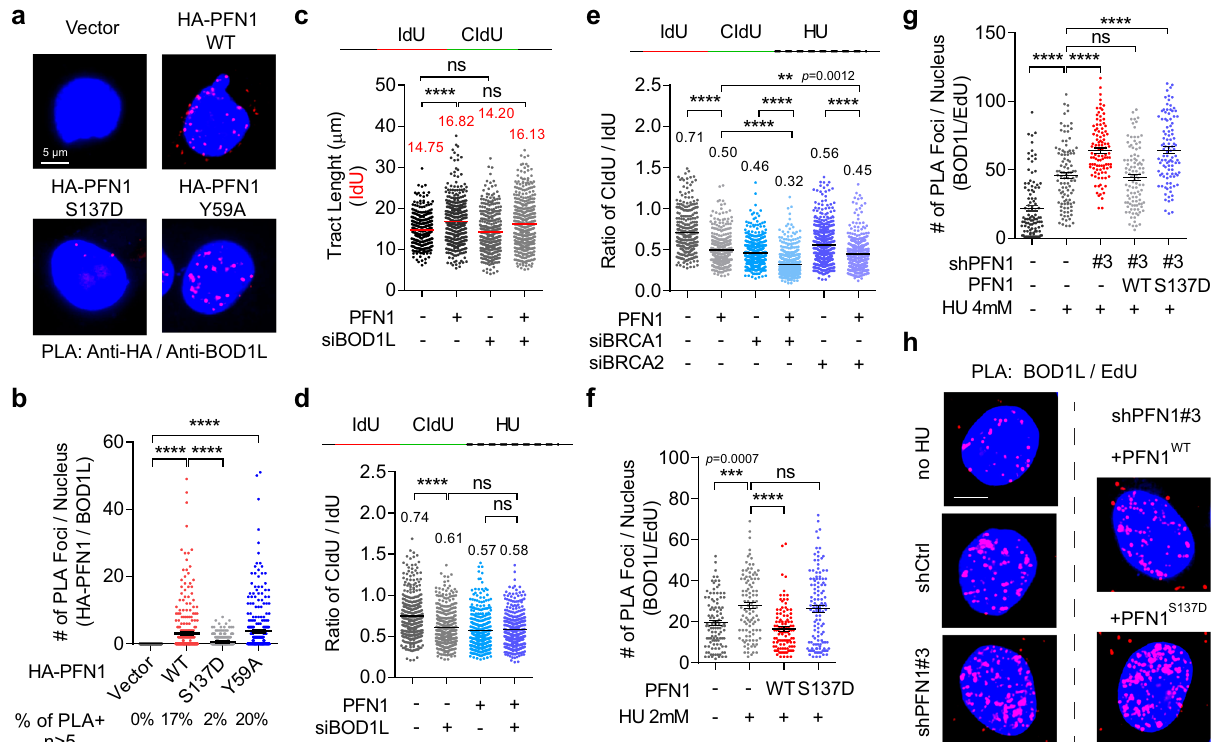
Fig. 6 | PFN1 binds BOD1L and suppresses its fork-protective activity. a RepresentativePLAimagesfortheinteractionbetweenHA-PFN1andendogenous BOD1LinHeLacells.Scalebar,5 µ m. b QuantitativeanalysisofHA-PFN1/BOD1LPLA in( a )based onfocinumberpernucleus(>5considered positive),and percentages of PLA-positive nuclei out of around 300 DAPI-positive total cells analyzed, as described in (1 c and 2 f ). c DNA fi ber analysis of dual-labeled PFN1-overexpressing HeLa cells transfected with control or BOD1L siRNAs, as in (1 e – j ). d , e Ratios of CIdU/IdU tract lengths in dual-labeled and subsequently HU-treated (2mM, 2h) MCF-10A cells overexpressing PFN1 and transfected with control or siRNAs